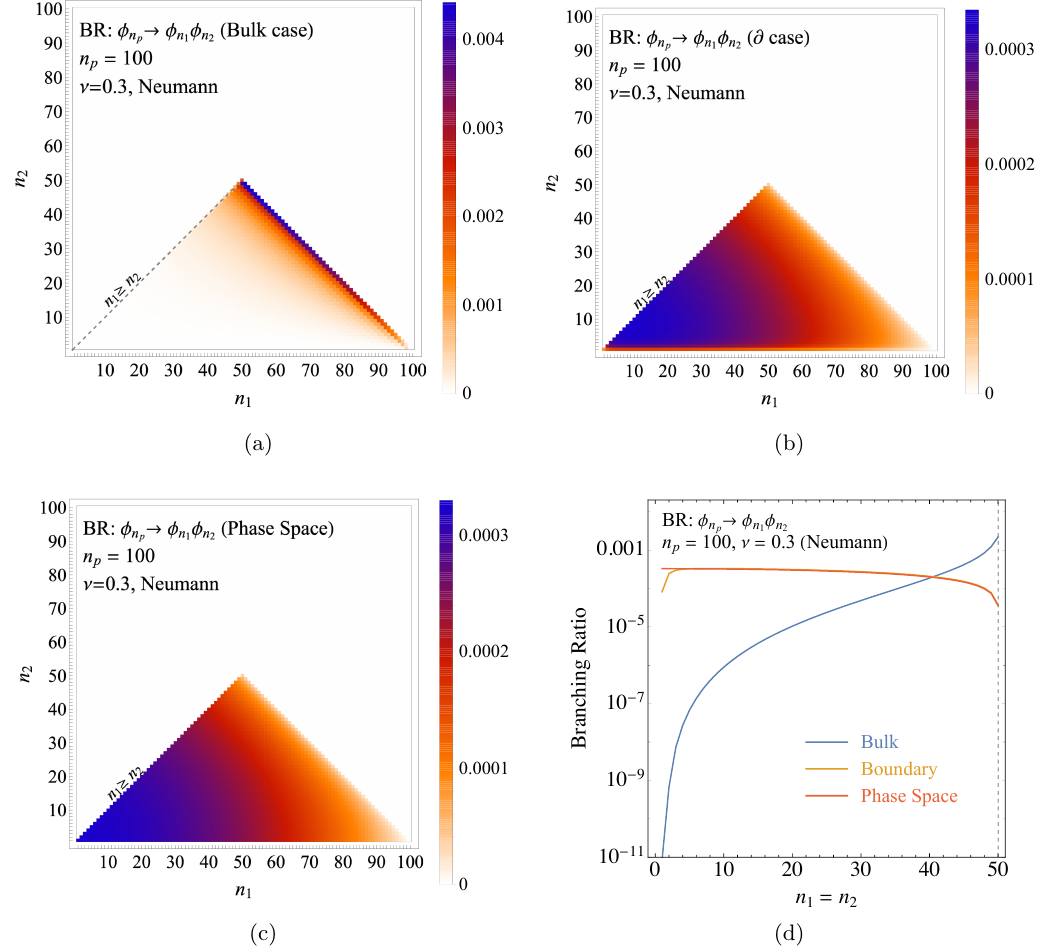
Figure 11 . The branching ratios for ν = 0 . 3 of the 100 th KK mode into all kinematically allowed two-body final states, in scenarios with Neumann boundary conditions. The cases are (a) bulk couplings; (b) boundary-localized coupling; and (c) pure phase space. In (d), we show a 1d plot of the branching ratios along the n = n line. For the boundary-localized case (b), in contrast 1 2